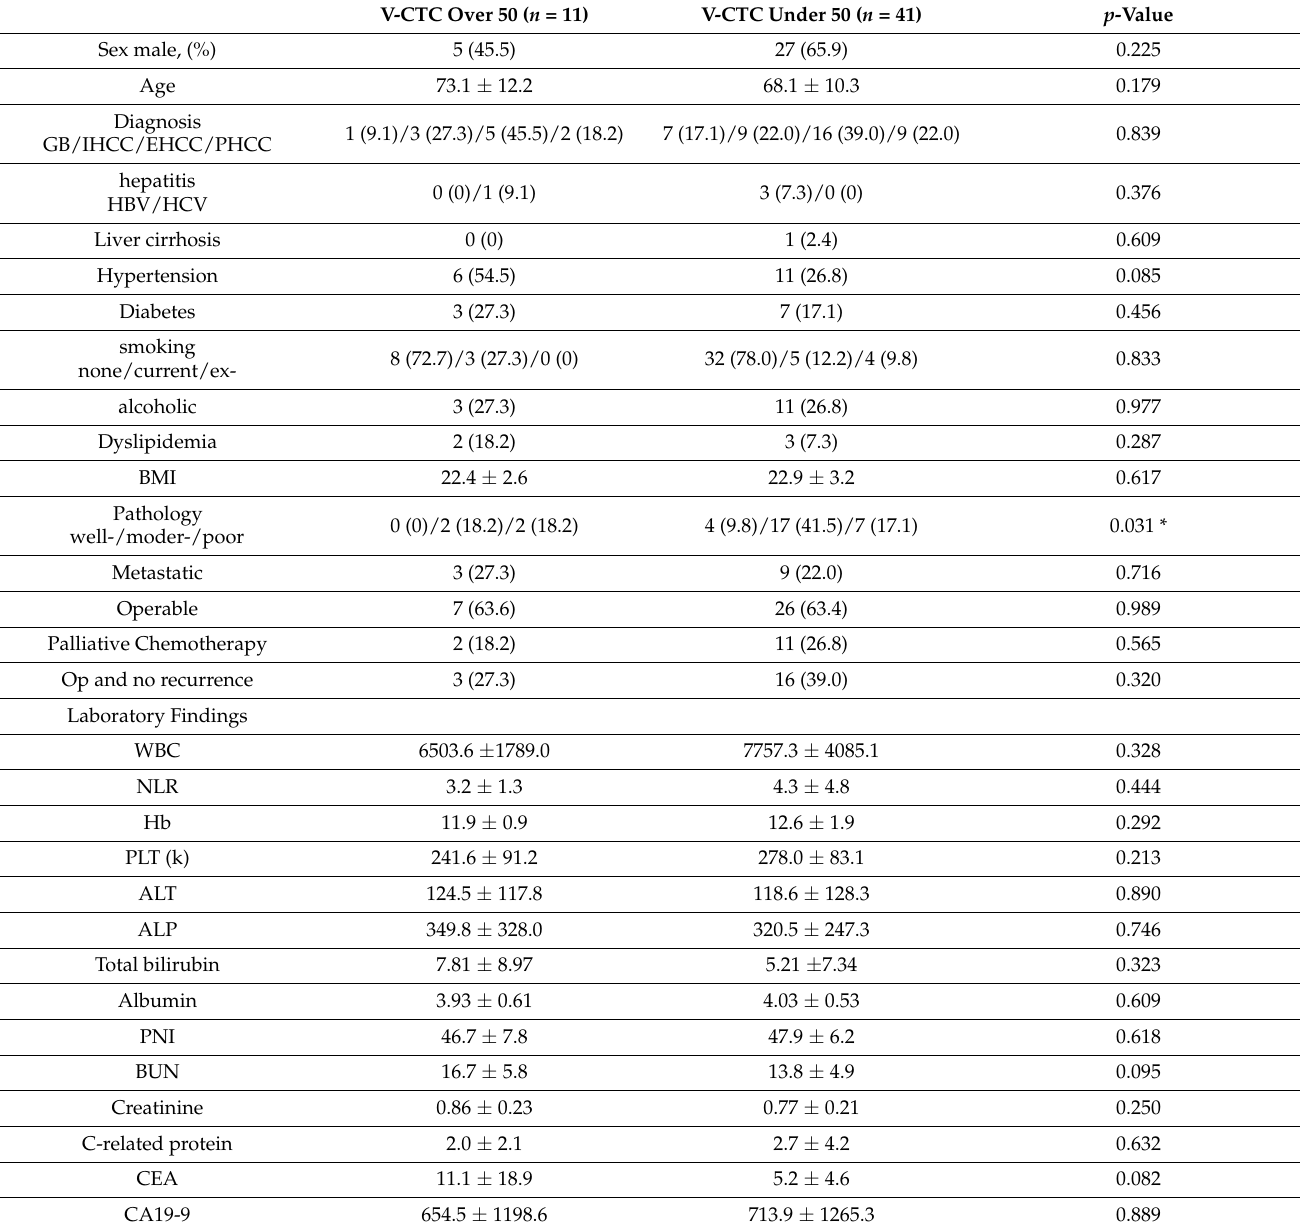
Table 5. Baseline characteristics according to V-CTC